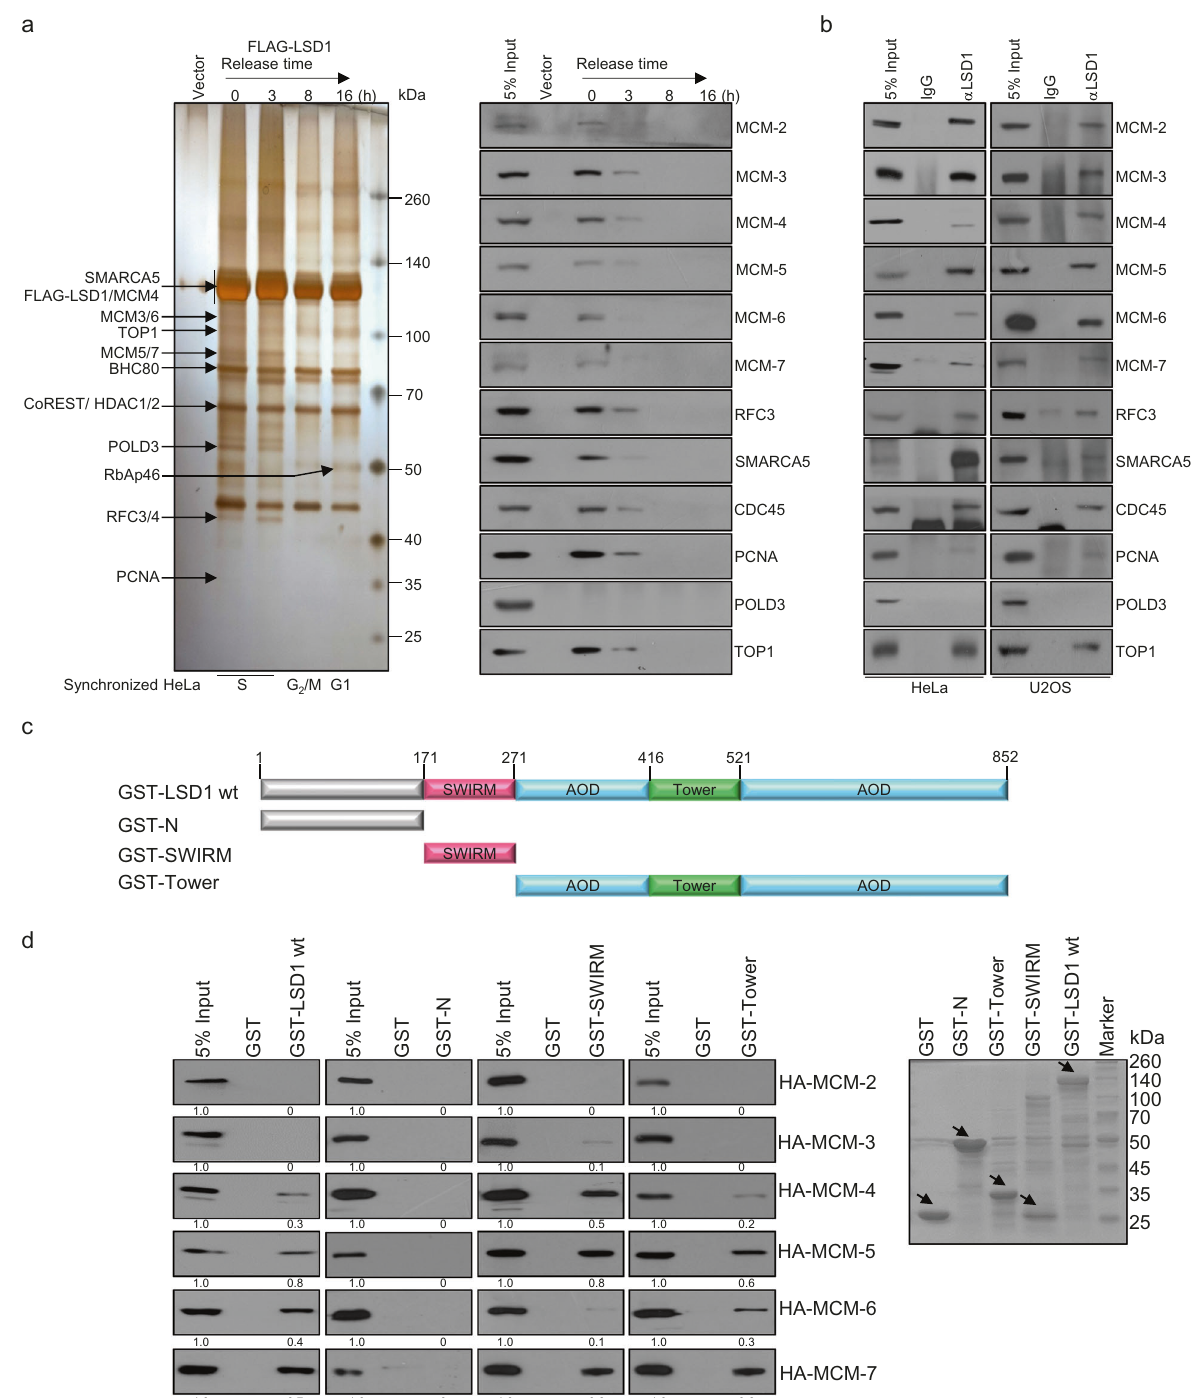
Fig. 1 LSD1 interacts with the DNA replication machinery. a Immunoaf fi nity puri fi cation of LSD1-containing complexes. HeLa cells stably expressing FLAG-LSD1 were synchronized by double-thymidine block. Cellular extracts were immunopuri fi ed with anti-FLAG af fi nity columns and eluted with FLAG peptides. The eluates were resolved by SDS-PAGE and visualized by silver staining. The proteins bands were retrieved and analyzed by mass spectrometry (left). Column-bound proteins were analyzed by western blotting using antibodies against the indicated proteins (right). The percentage of input was 5%, the same for the experiments described below. b Immunoprecipitation of endogenous proteins in S-phase HeLa and U2OS cells with antibodies against LSD1, followed by immunoblotting with antibodies against the indicated proteins. c Schematic representation of the structure of LSD1. d GST pull-down assays with GST-LSD1, GST-N (1-171 aa), GST-SWIRM (171-271 aa), and GST-Tower (416-521 aa) and in vitro transcribed/translated MCM2-7. Coomassie brilliant blue (CBB) staining of GST-fused wild-type and deletion mutants of LSD1 is shown (arrows)